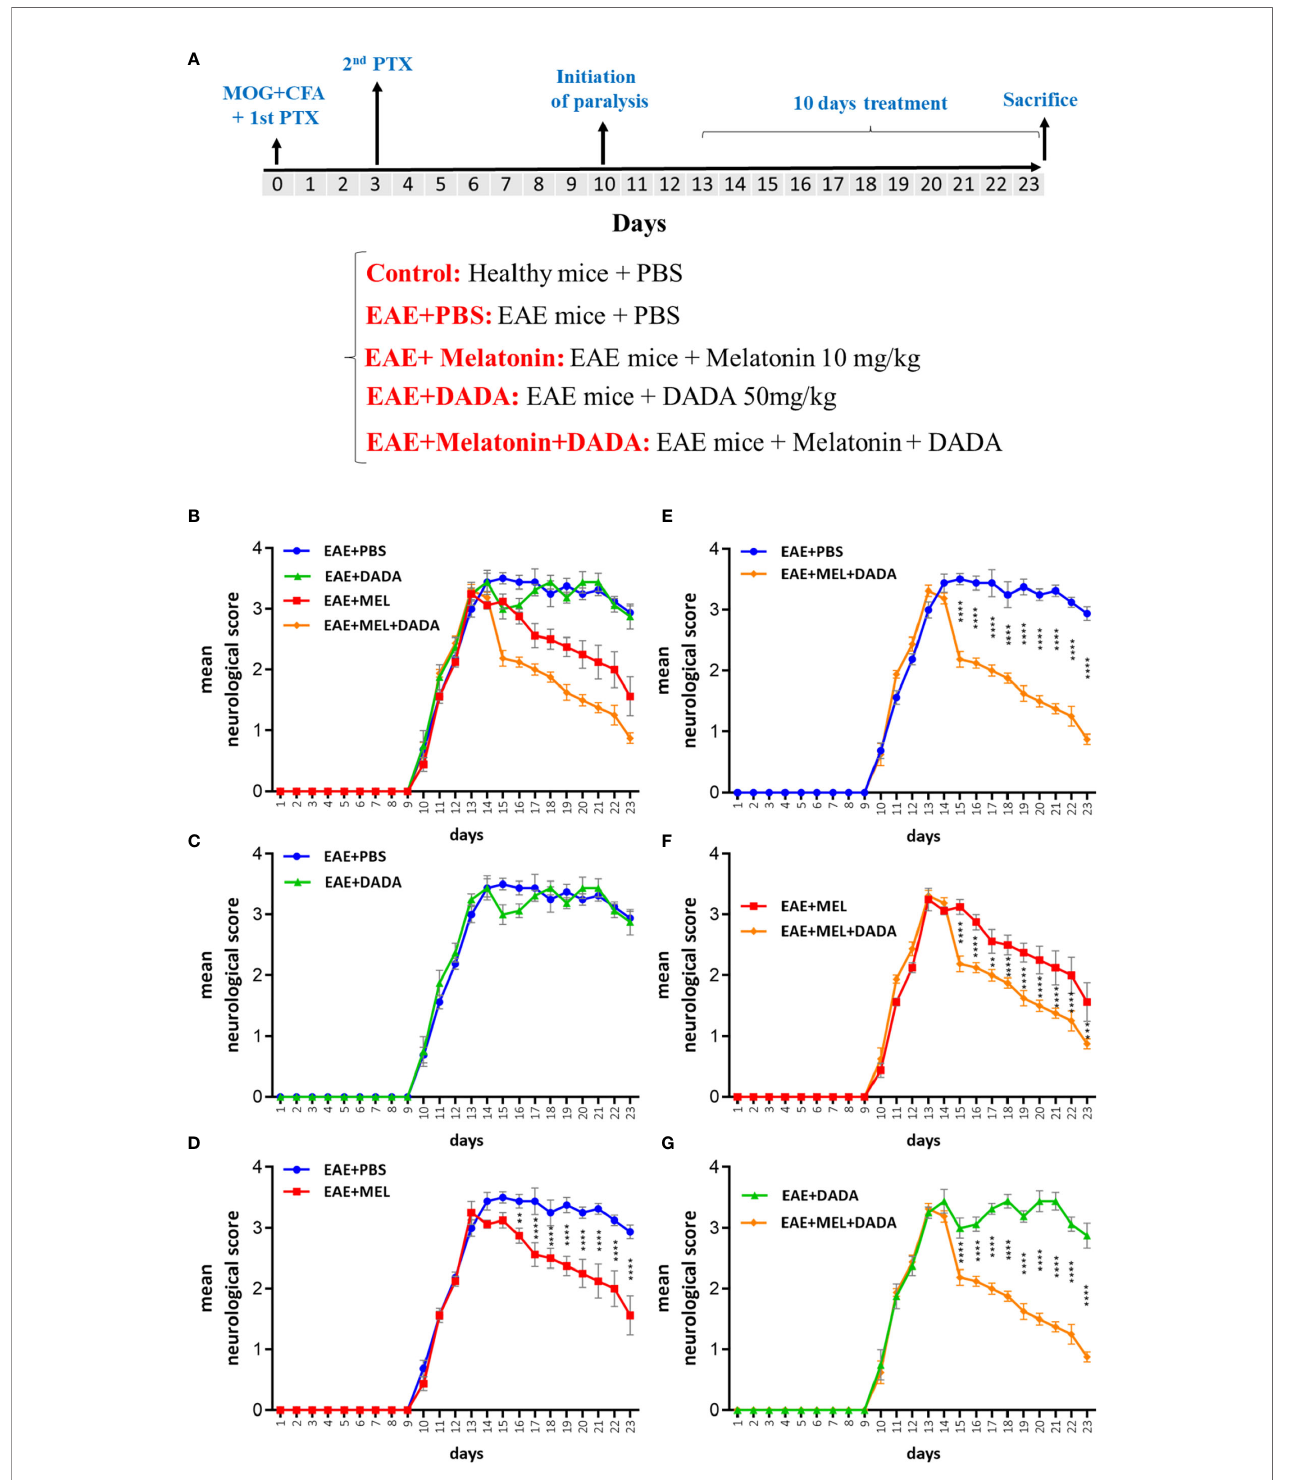
FIGURE 1 | (A) Schematic representation of experiment procedures and (B – G) daily assessment of EAE severity. Neurological disability analysis displayed an amelioration in EAE disease severity in melatonin (EAE+MEL) and combined therapy of melatonin and DADA (EAE-MEL+DADA), but not DADA alone. Treatment was initiated from day 13 post immunization for 10 consecutive days. (n=8